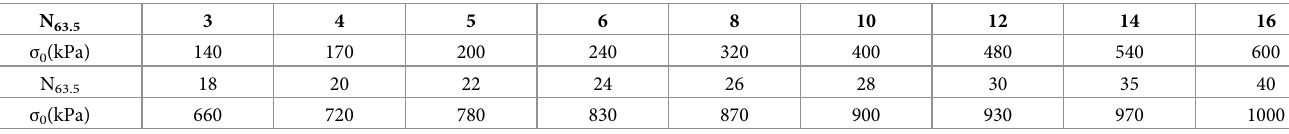
Table 5. Relationship between N 63.5 and bearing capacity.